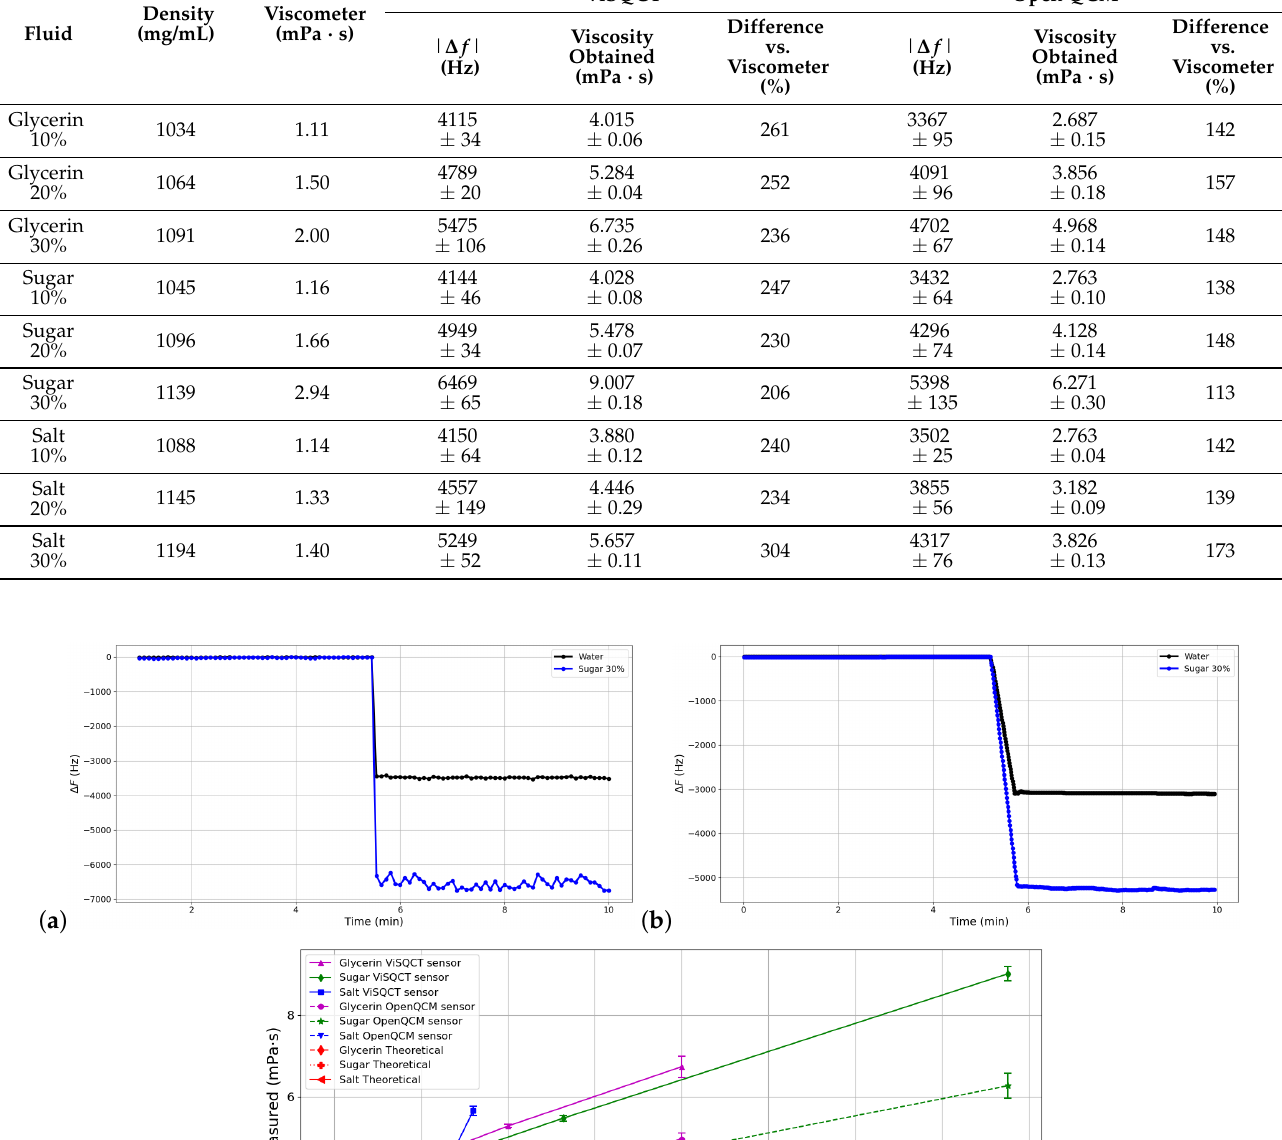
Table 4. Glycerin, Sugar, and Salt concentrations parameters and results with both sensors.